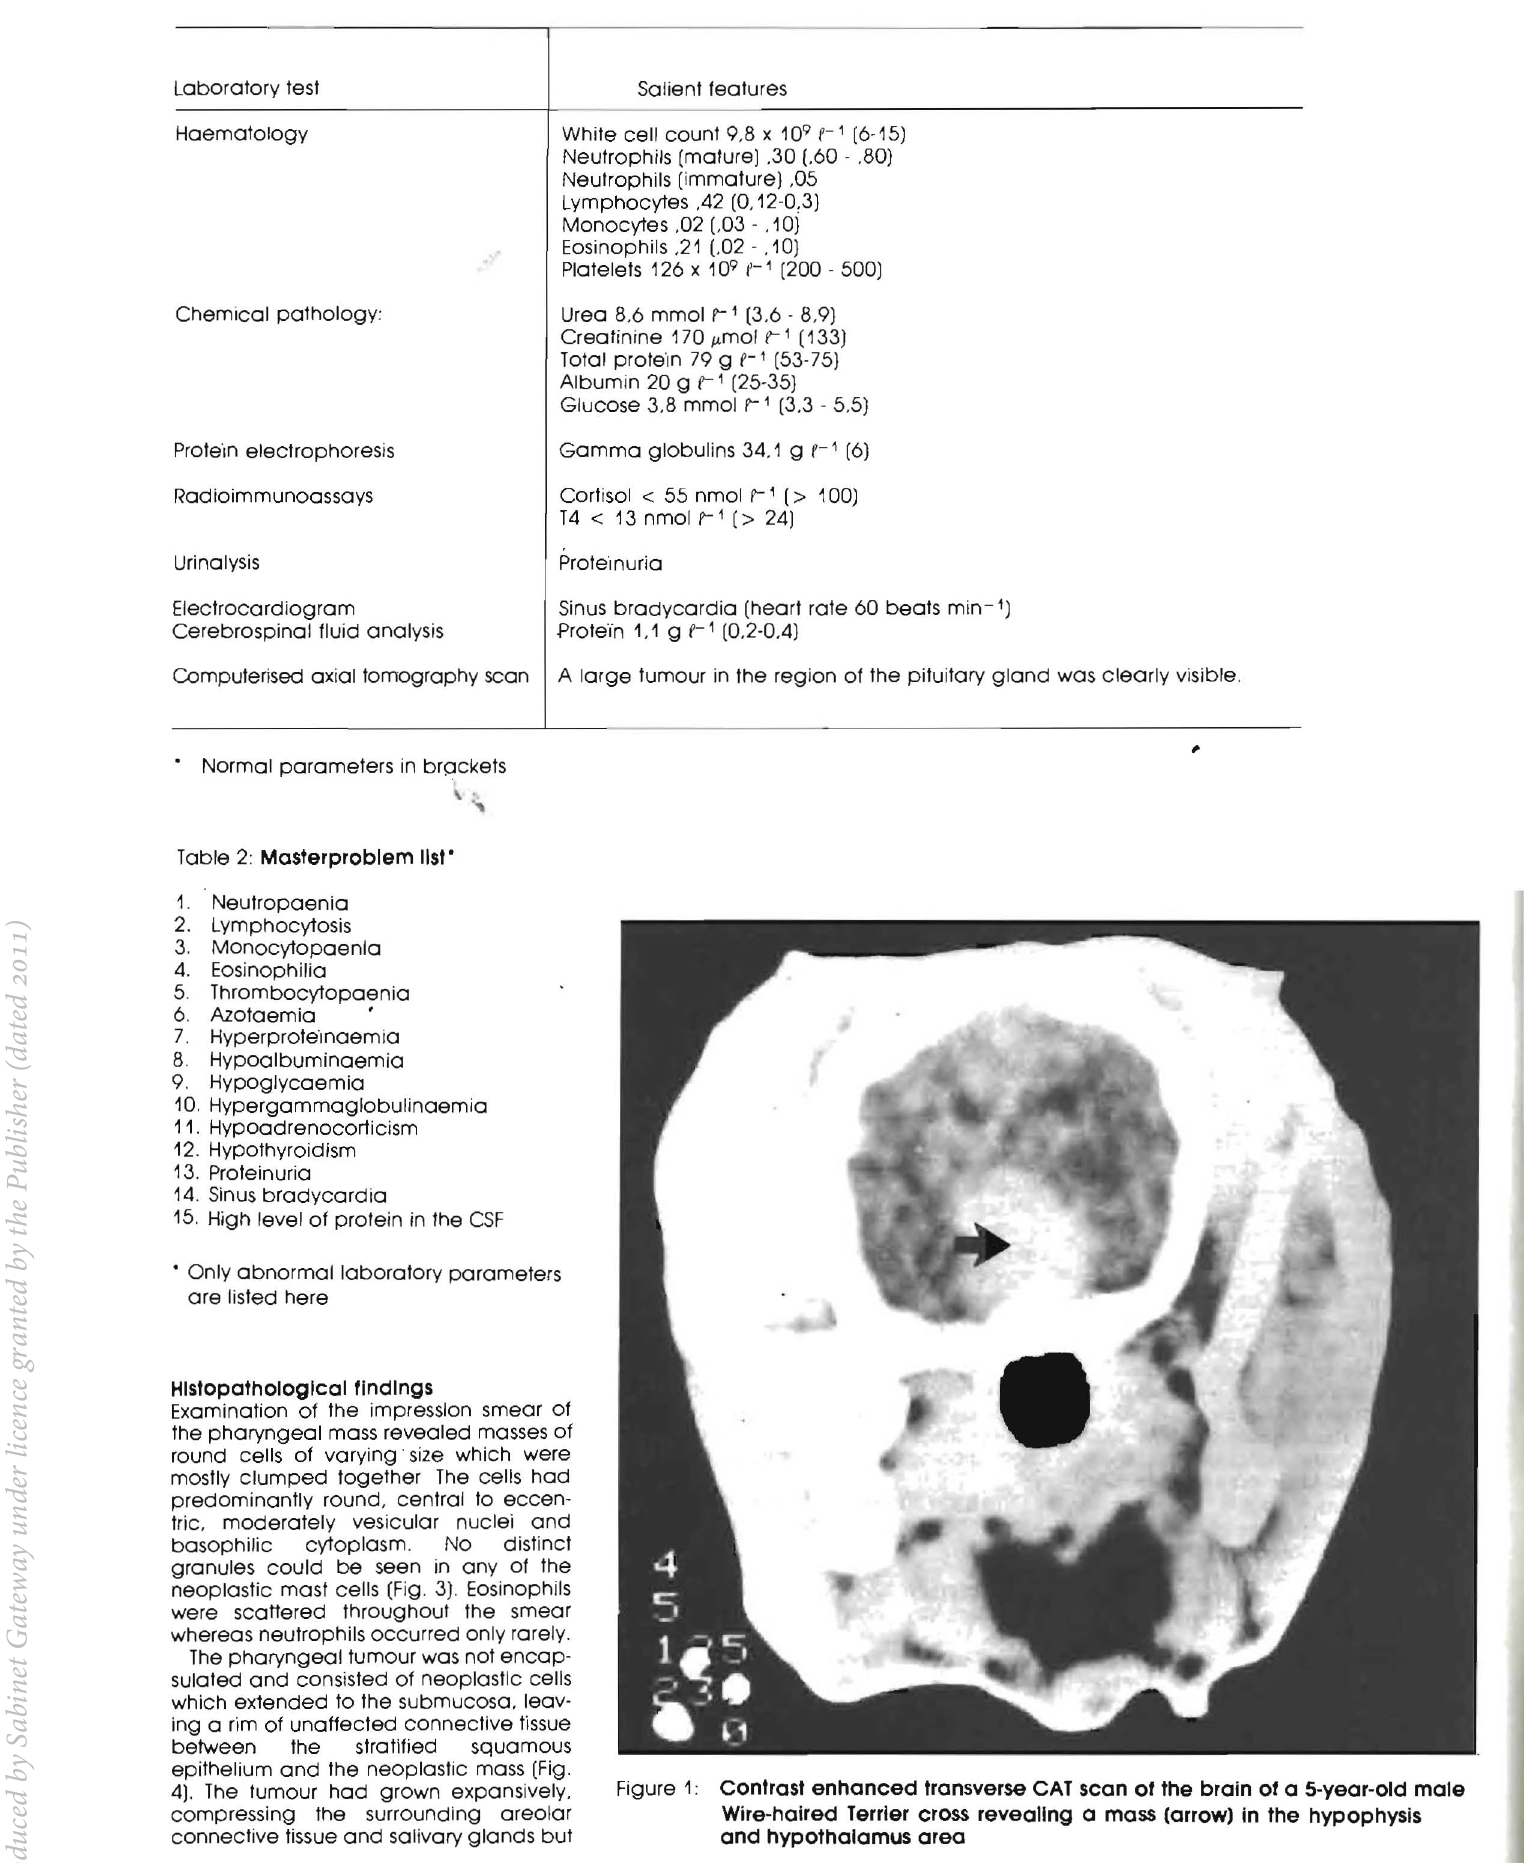
Figure 1: Contrast enhanced transverse CAT scan ot the brain ot a 5-year-old male Wire-haired Terrier cross revealing a mass (arrow) In the hypophysis and hypothalamus area 0038-2809 Tydskr. S. Afr. vet. Ver. (1989)60(2):